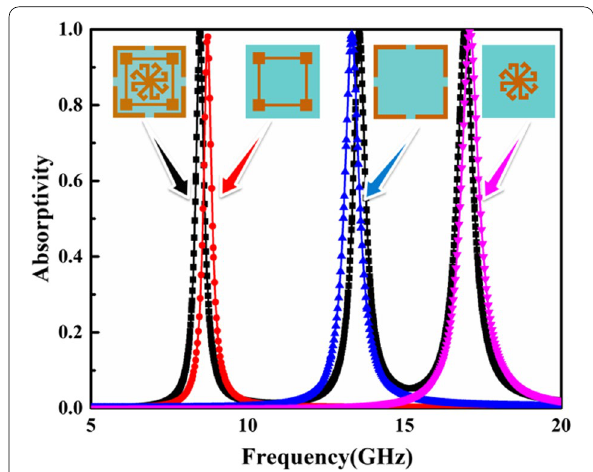
Fig. 3 Contribution from individual elements to absorption